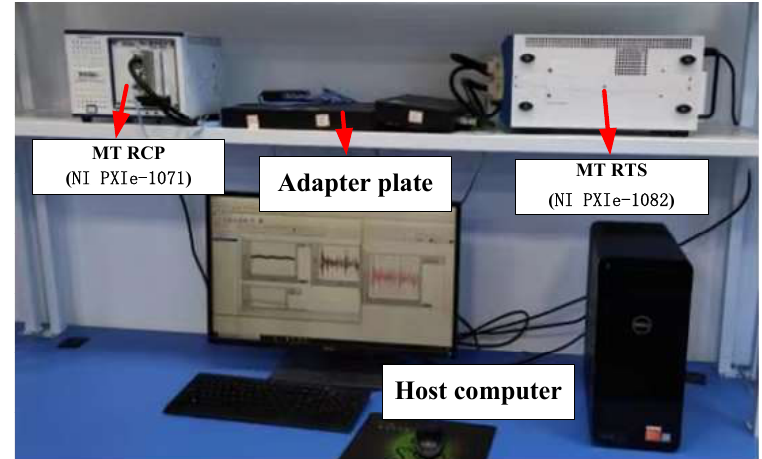
Figure 3. The environment used for the actual experiment.